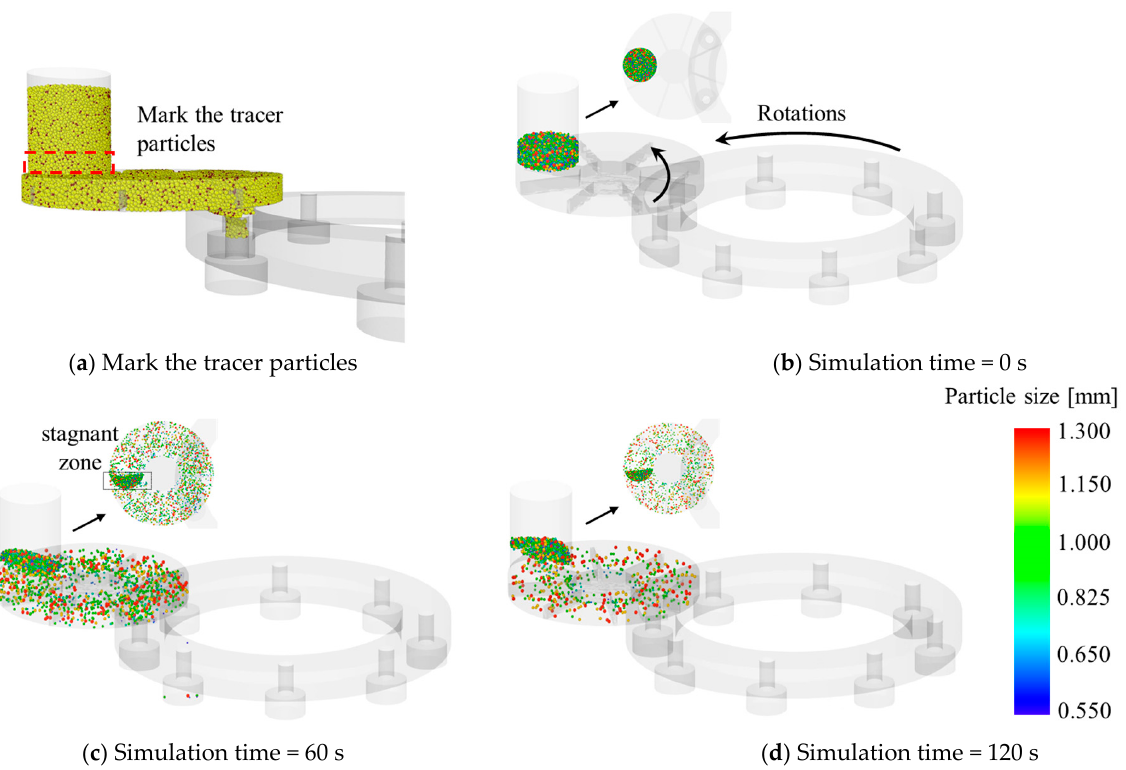
Figure 3. ( a ) Marked particles in the lower quarter of the hopper at the hopper feeder interface. The paddle speed and turret speed are both set at 20 RPM. ( b ) The positions of the tracer particles before the simulation starts. ( c ) The positions of the tracer particles when the simulation time is 60 s. ( d ) The positions of the tracer particles when the simulation time is 120 s.